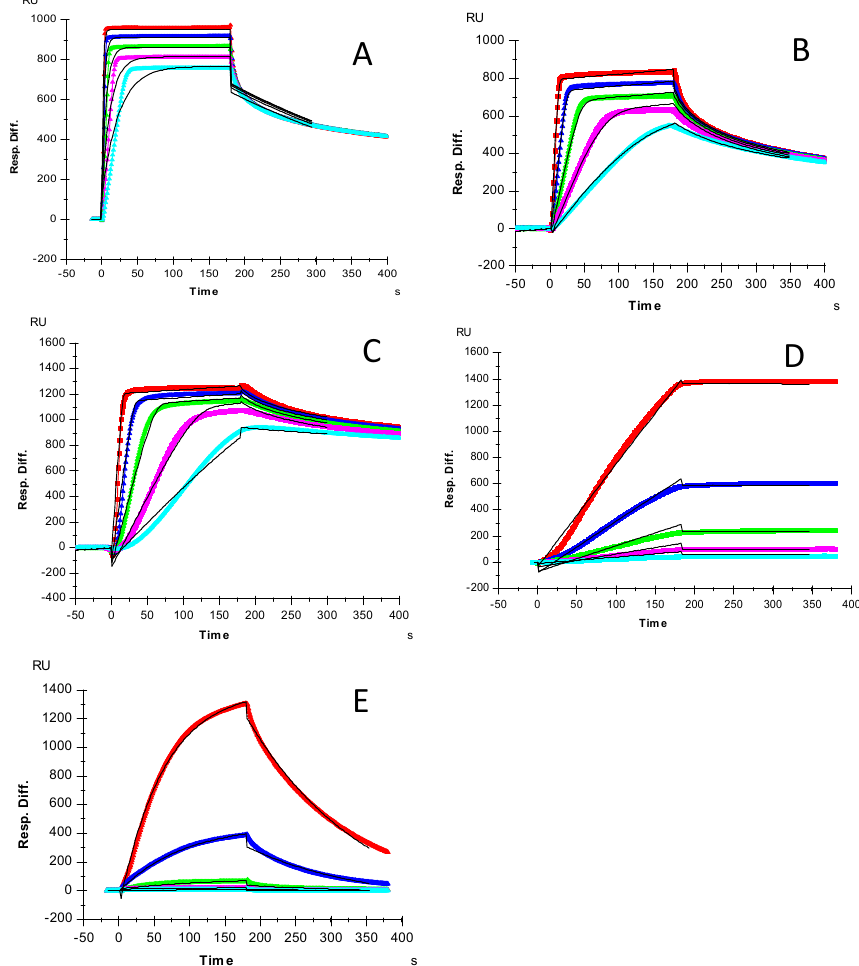
Figure 2. SPR sensorgrams for binding kinetics/affinity measurements for growth factor-heparin interactions: ( A ) FGF2, concentrations of the FGF2 (from top to bottom) were 32, 16, 8, 4, and 2 μM, respectively; ( B ) FGF7, concentrations of the FGF7 (from top to bottom) were: 250, 125, 63, 32 and 16 nM, respectively; ( C ) FGF10, concentrations of the FGF10 (from top to bottom) were: 250, 125, 63, 32 and 16 nM, respectively; ( D ) HGF, concentrations of HGF (from top to bottom): 20, 10, 5, 2.5 and 1.25 nM, respectively. ( E ) TGFβ-1, concentrations of TGFβ-1 (from top to bottom): 100, 50, 25, 12.5 and 6.3 nM, respectively. The black curves are the fitting curves using a 1:1 Langmuir model from BIAevaluation 4.0.1. Table 1. Summary of kinetic data of growth factor-heparin interactions *. Interactions